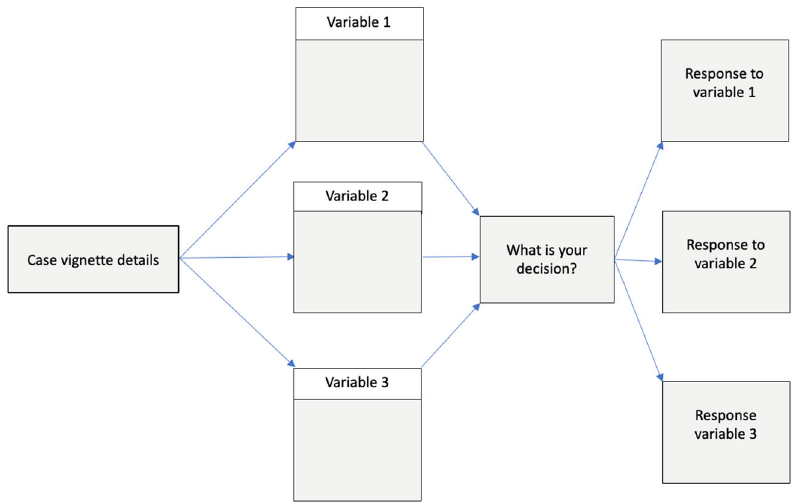
Figure 1. Flow map showing how case vignette details begin the narrative aimed at describing variation. Three variables are each independently added to the narrative to isolate the impact of each variable alone on the decision in response to the variable.